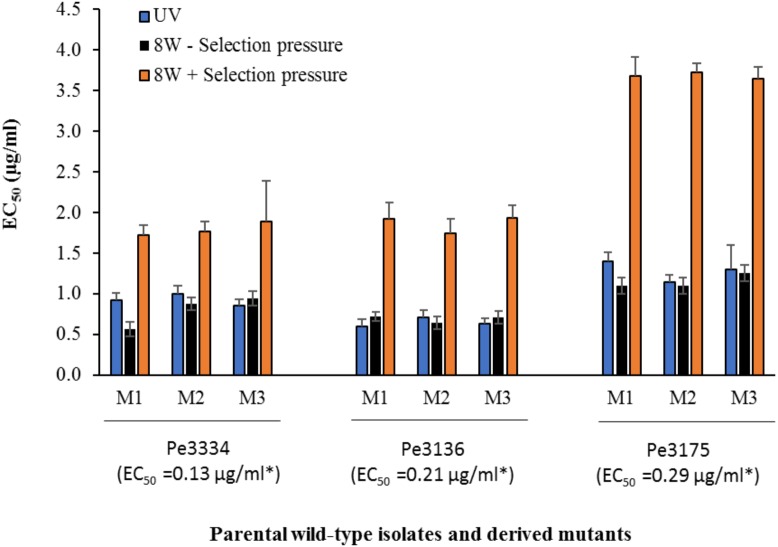
Mean effective concentration for 50% growth inhibition values (EC50) of difenoconazole for DIF-resistant mutants selected following UV excitation of Pe3334, Pe3136, and Pe3175 P. expansum isolates or after 8 weeks of adaptation on MEA amended with DIF at 2.5 μg/ml (+ selection pressure, orange bars) or without (– selection pressure, black bars) at 22°C. Asterisks indicates the EC50 values of each parental WT-isolate. Data are the mean of 12 values across two experimental runs for each mutant.